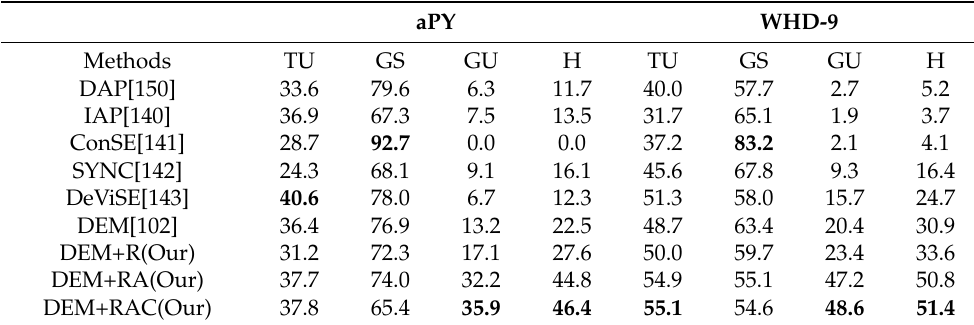
Table 3. Experiment results based on aPY and